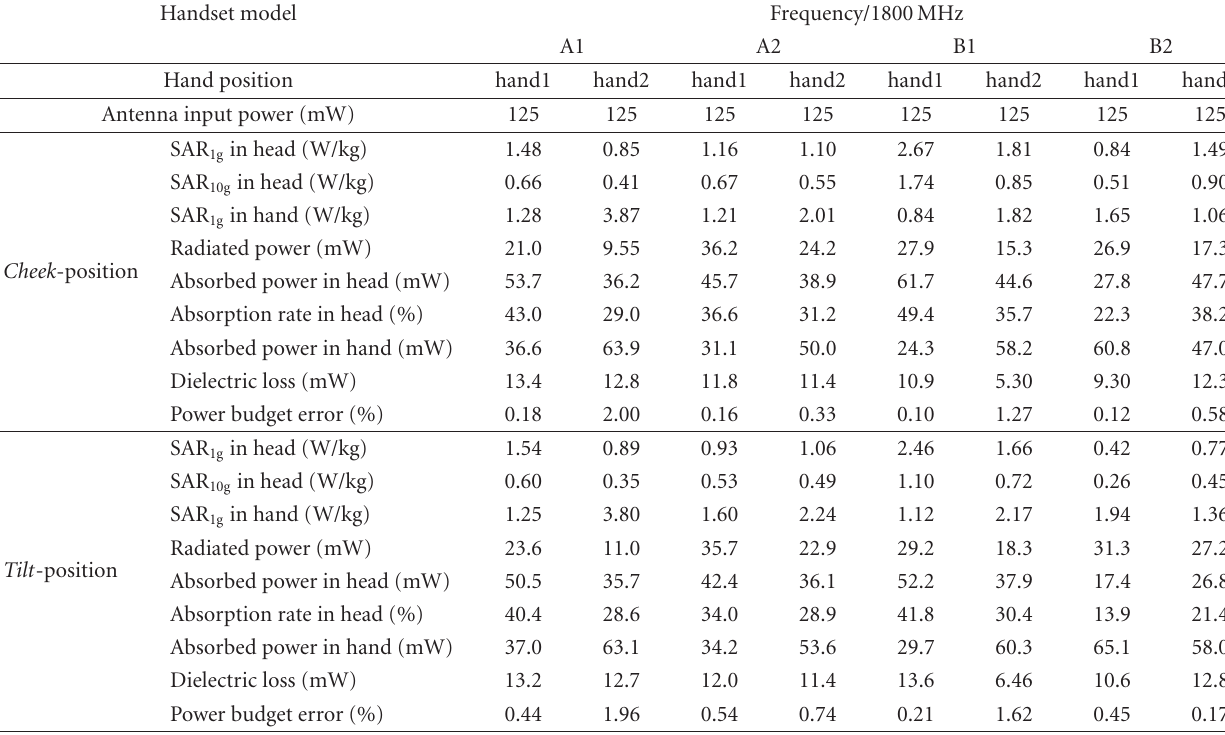
Table 9: Pooled statistics of peak 1 and 10 g SAR in tissues, radiated power, absorbed power in tissues, dielectric loss, and power budget error for the handset models in hand closed to HR-EFH at di ff erent positions operating at 1800 MHz.